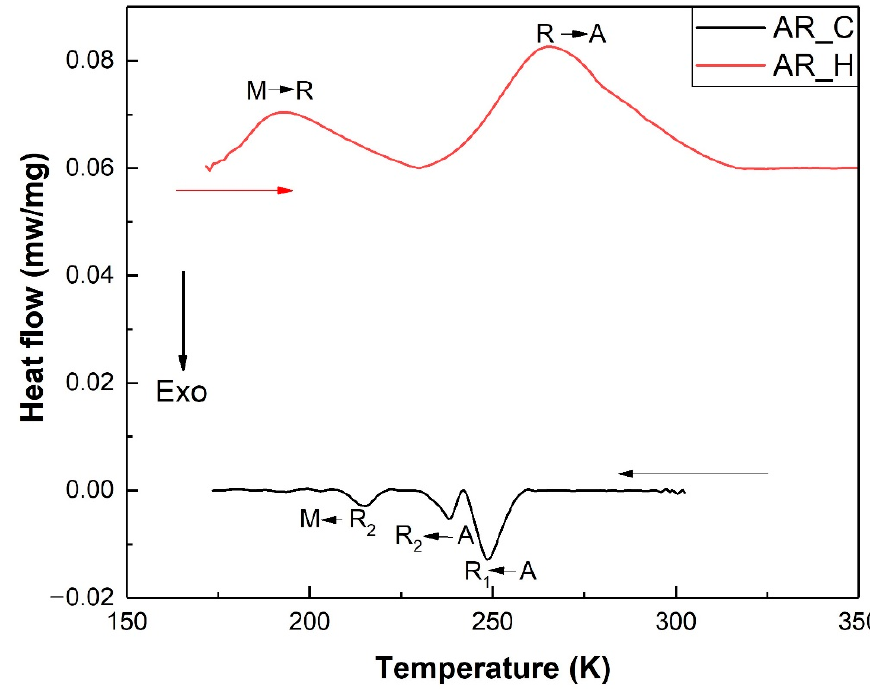
Figure 2. DSC thermograms of the as-received Nitinol during heating and cooling at 10 K/min. The exothermic transformation was happening in stages indicating the high amount of cold work.